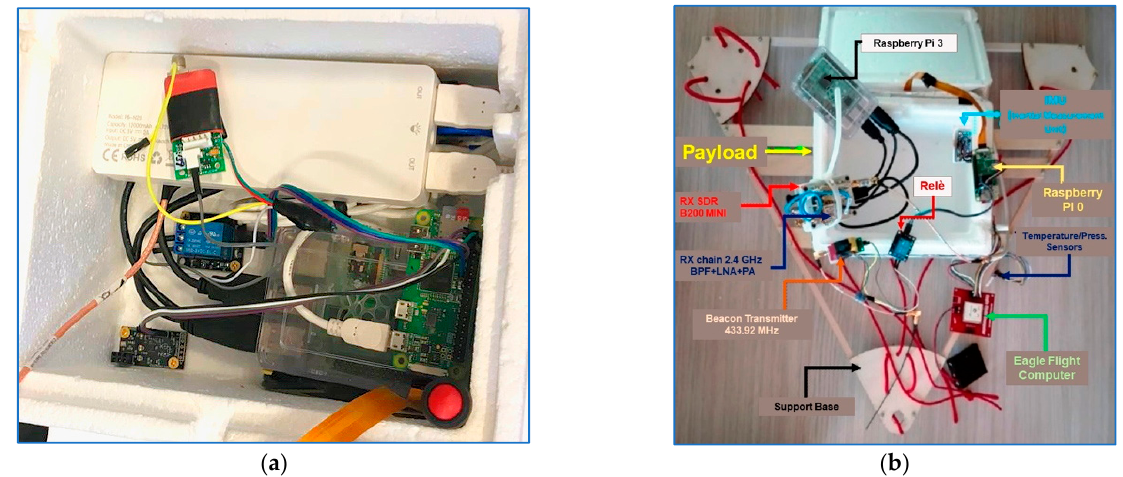
Figure 3. The ISM-HAB payload gondola: ( a ) the main payload Styrofoam box, and ( b ) arrangement of the box and other components on the base frame.